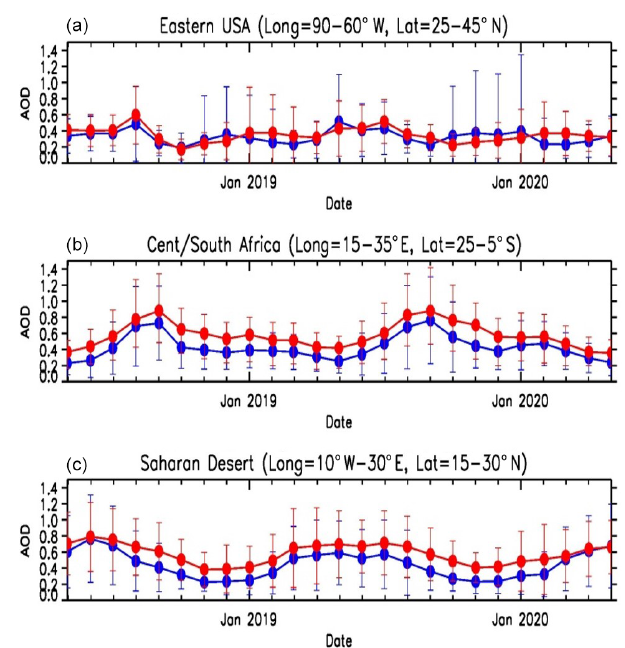
Figure 5. The 2-year time series of monthly average OMI (in red) and TROPOMI (in blue) 388nm AOD values for the eastern United States (a) , southern Africa (b) , and Saharan desert (c) . Vertical lines indicate the standard deviation of the mean associated with both temporal and spatial variability.